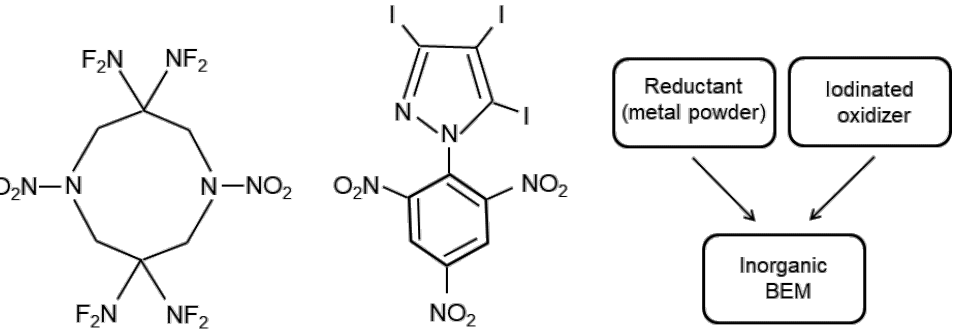
Figure 3. Left image: example of a single-block organic BEM containing haloamine groups (HNFX; 3,3,7,7-tetrakis (difluoramino) octahydro-1,5-dinitro-1,5-diazocine). Central image: example of a multiblock organic BEM (3,4,5-triiodo-1-(2,4,6-trinitrophenyl)-1H-pyrazole). Right image: simplified scheme of a process where an iodinated inorganic BEM is obtained by mixing, where iodine is contained in the oxidizer.